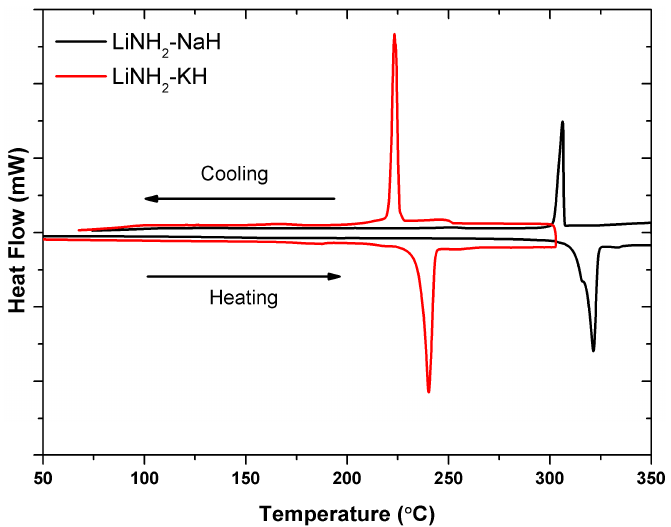
Figure 3. DSC thermogram of 0.5LiNH 2 -0.5NaH and 0.5LiNH 2 -0.5KH composite samples. The DSC measurements were performed under the closed conditions under a 0.5 MPa H 2 atmosphere up to 370 °C with a heating rate of 5 °C/min.